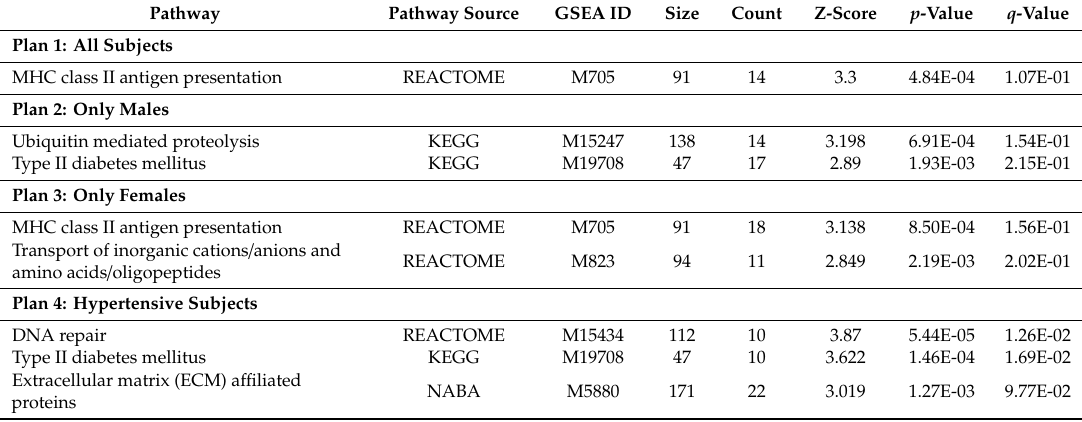
Table 5. Pathway-enrichment of brain-specific methylome-wide association